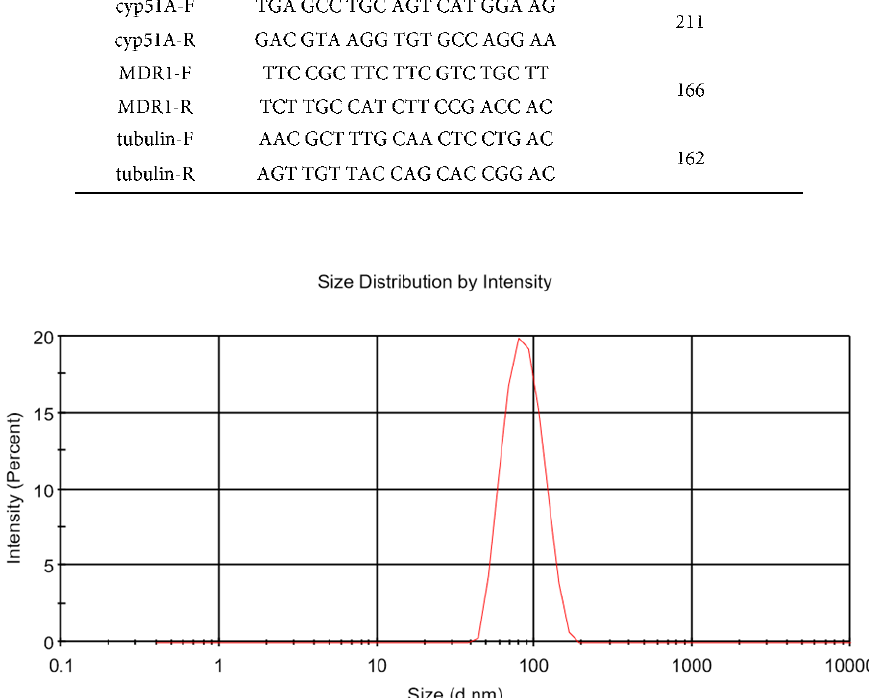
Fig.1. Particle-size distribution spectrum of VCZ-loaded nano-liposome